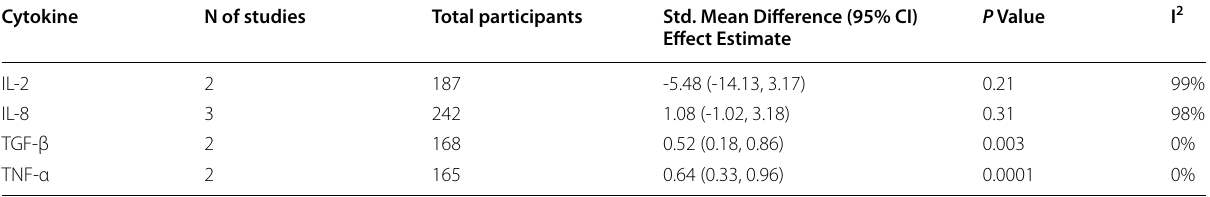
Table 4 Differences in circulating cytokines levels between patients with tension-type headache and healthy